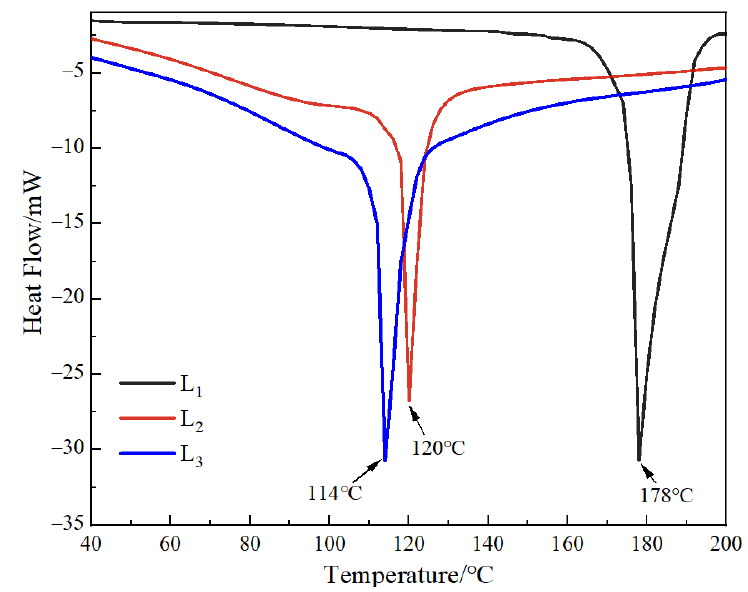
Figure 4. DSC thermograms of L 1 , L 2 , and L 3 . L 1 : the 2.5% SA one-layer-gel microspheres; L 2 : the 2.5% SA two-layer-gel microspheres; L 3 : the 2.5% SA three-layer-gel microspheres.